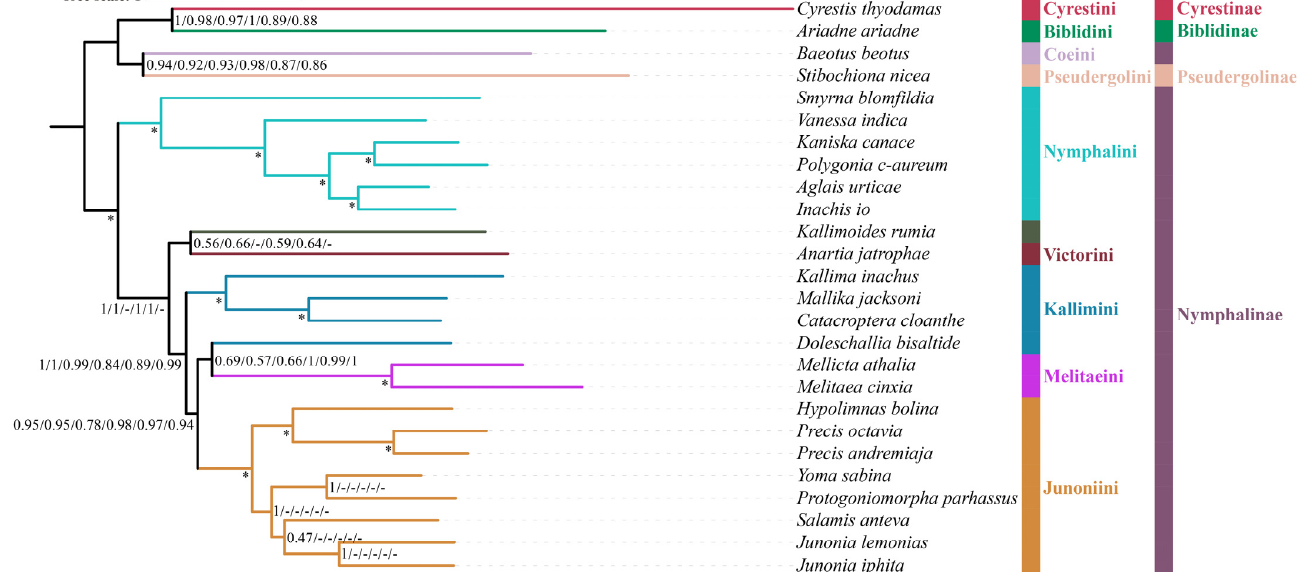
Figure 4. Phylogenetic analysis using the BI method based on the datasets of PCG123, PCG123R, PCG123RT, PCG123N, PCG123RN, and PCG123RTN. Posterior probability (BPP) values at nodes (from left to right) represent support for PCG123, PCG123R, PCG123RT, PCG123N, PCG123RN, and PCG123RTN datasets, respectively. The “-” indicates the clades are di ff erent. Maximum support values produced are indicated by star symbols.